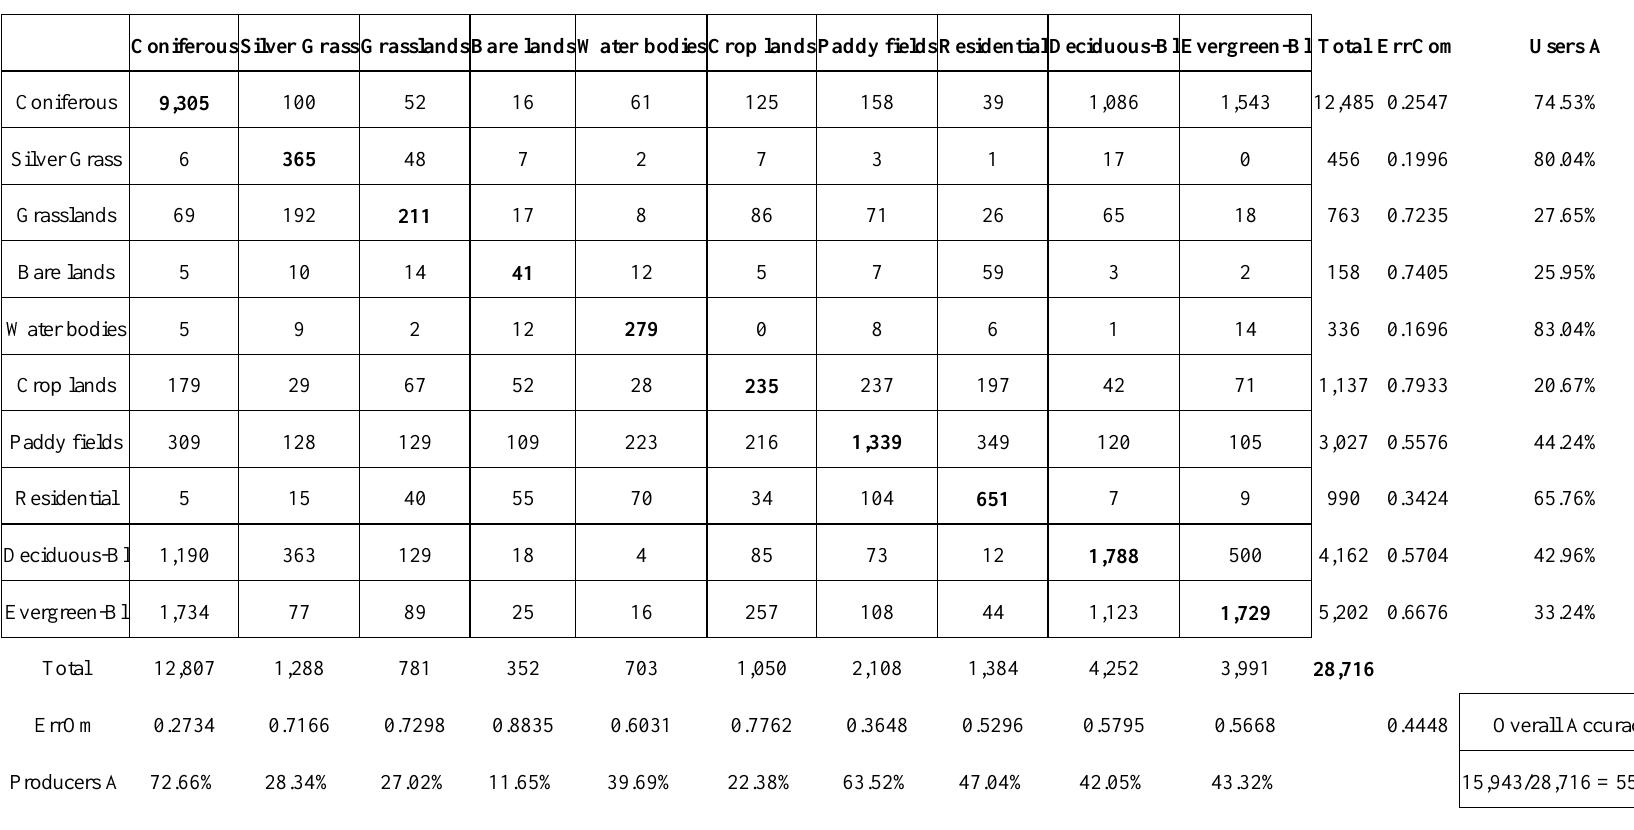
Table 3. The error matrix for the classified LU/LC map. Area for ground truth categories, together with the Commission Errors (ErrCom), are given in the columns, while the areas for the classified categories and the Omission Errors (ErrOm) are given in the